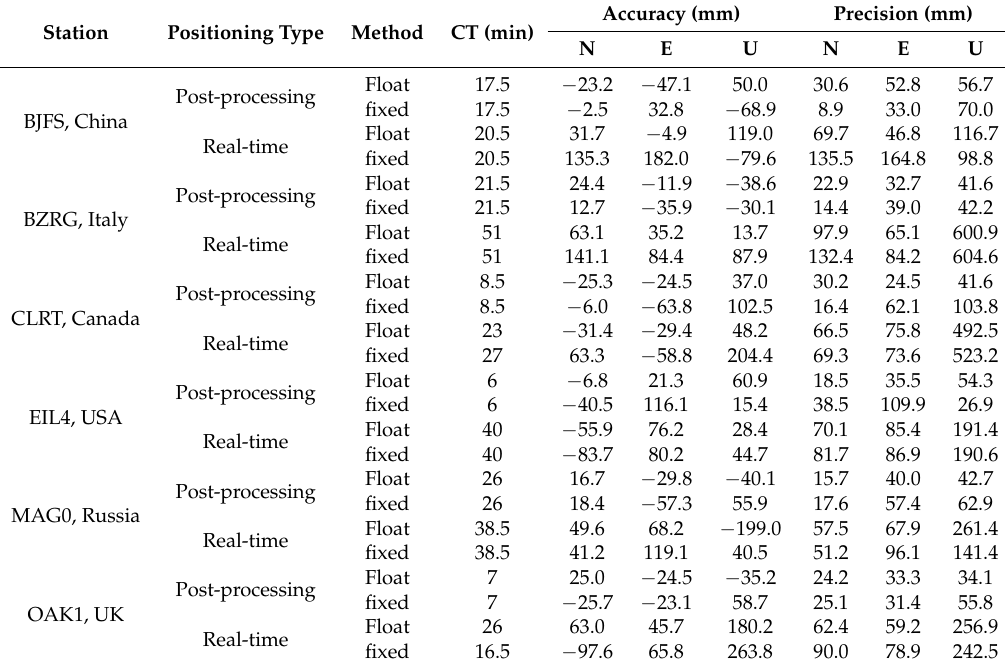
Table 5. Positioning performance at different stations with a stable float